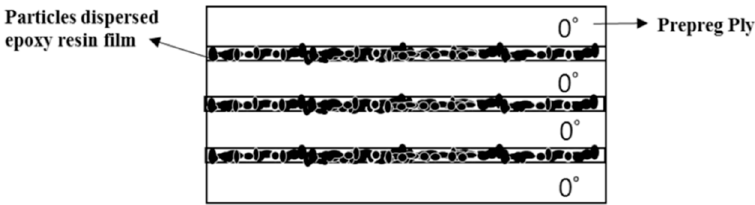
Figure 1. Illustration of the cross-section of the CFRP specimen interleaved with the particle-dispersed mixture film.